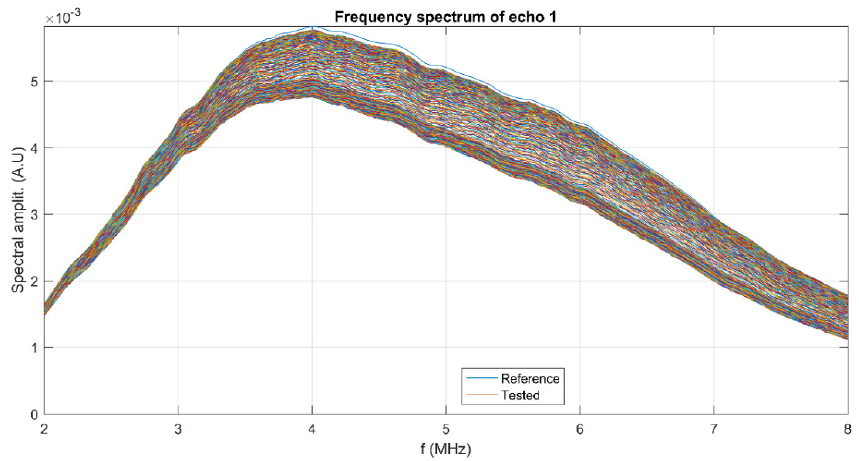
Figure 3. Frequency spectrum of the first transmitted echo.